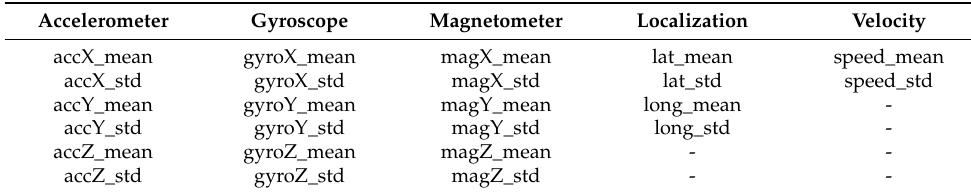
Table 3. Parameters of the